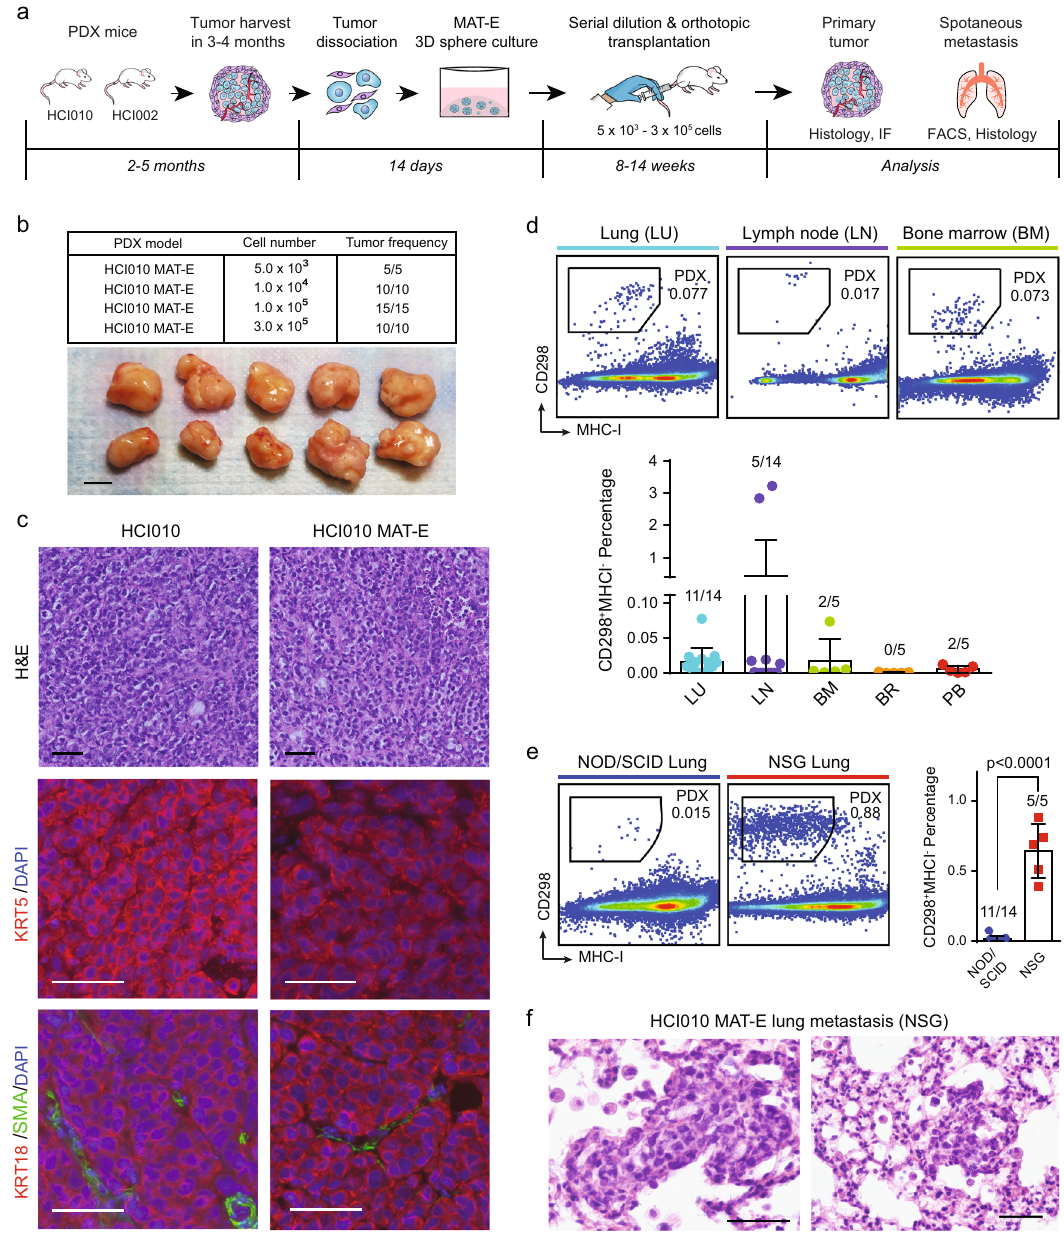
Fig. 3 PDX tumor sphere cells maintain tumorigenic potential and form spontaneous metastasis in vivo. a Schematic overview of work fl ow and timeline for assessing the capacity of cultured PDX cells to generate primary tumors and spontaneous metastasis following orthotopic transplantation. b Serial dilution and transplantation analysis to determine the tumorigenic capacity of cultured cells. HCI010 cells were cultured in MAT-E conditions and injected orthotopically into NOD/SCID mice at increasing dilution (5.0 × 10 3 − 3.0 × 10 5 ). Table (top) shows the fraction of tumors generated at each dilution. Representative images (bottom) show primary tumors generated from orthotopic transplantation of 1 × 10 5 cells. Scale bar = 1 cm. c Histopathological and molecular marker analysis of tumors generated from uncultured (HCI010) and cultured (HCI010 MAT-E) cells. The top panels show the representative histopathological appearance of tumor sections stained with hematoxylin and eosin (H&E). Scale bar = 50 µ m. The middle and bottom panels show representative images of IF staining for basal (KRT5), luminal (KRT18), and myoepithelial (SMA) cell markers. Scale bar = 50 µ m. d Quanti fi cation of spontaneous metastasis in animals transplanted with 1 × 10 5 cultured HCI010 cells. Representative plots (top) show quanti fi cation of CD298 + MHC-I − human metastatic PDX cells in distal tissues by fl ow cytometry. Bar graph (bottom) shows quanti fi cation of the percent of metastatic cells in a cohort of transplanted animals ( n = 5 – 14). Fractions indicate the number of tissues with metastasis, de fi ned by >0.005% CD298 + MHC-I − cells. Data are represented as the mean ± s.d. LU lung, LN lymph node, BM bone marrow, BR brain, PB peripheral blood. e Comparison of lung metastatic burden in NOD/ SCID and NSG animals transplanted orthotopically with 1 × 10 5 cultured HCI010 cells. Representative plots show CD298 + MHC-I − human metastatic PDX cells in the lungs 8 weeks after transplant by fl ow cytometry. The bar graph shows the quanti fi cation of the percentage of metastatic cells in a cohort of transplanted animals. P value determined by unpaired t test. Data are represented as the mean ± s.d. Fractions indicate the number of tissues with metastasis, de fi ned by >0.005% CD298 + MHC-I − cells. f Representative images of metastatic lesions in the lungs of NSG animals transplanted with cultured HCI010 cells identi fi ed by H&E staining and histopathological analysis. Scale bar = 50 µ